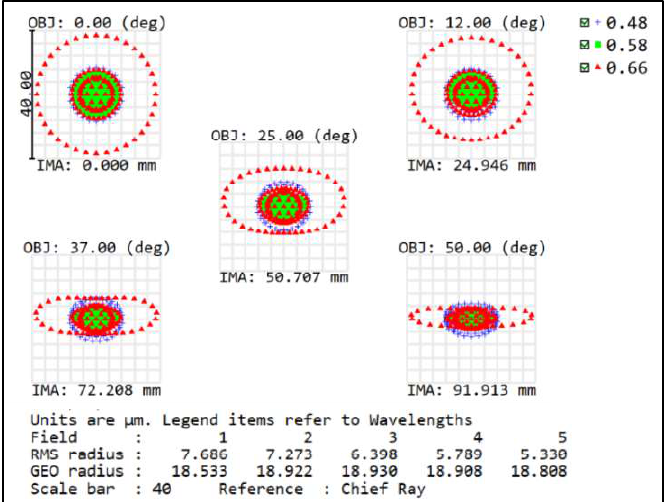
Figure 7. Spot diagram of the front concentric imaging group.